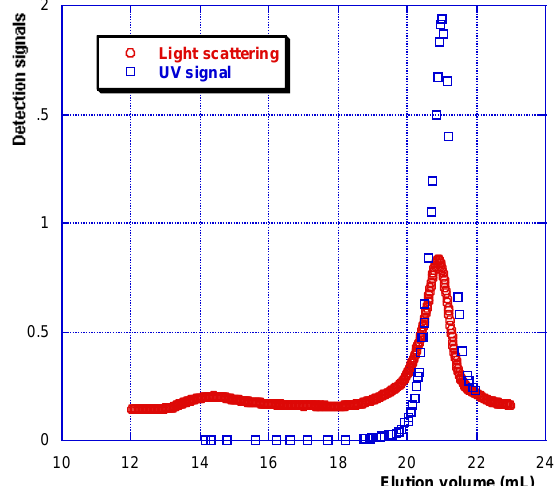
Figure 2. Specific UV identification of protein elution in SEC experiment on a synovial